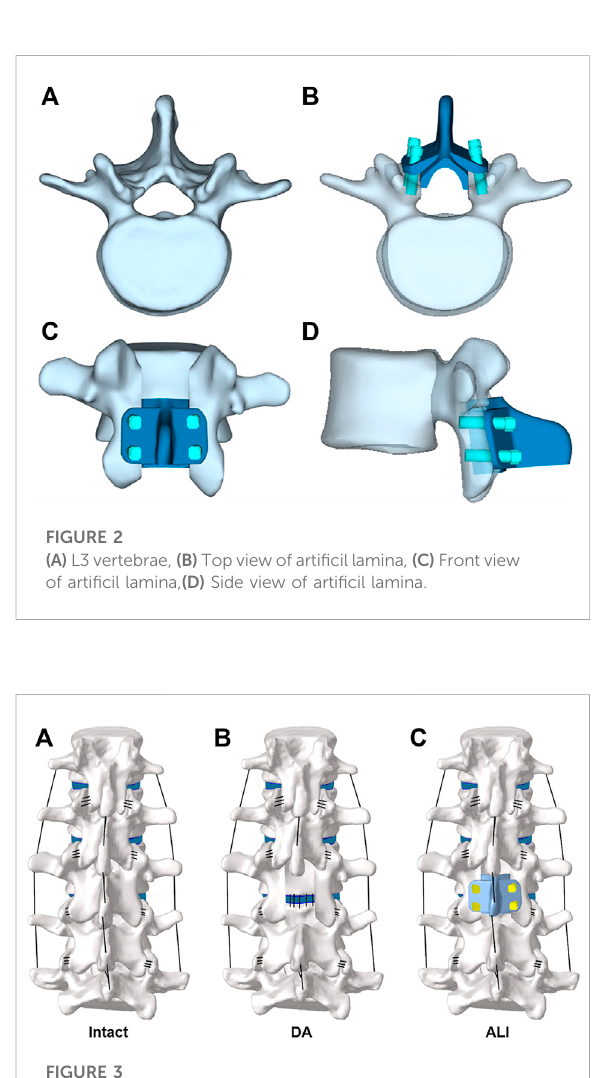
FIGURE 3 FE model of the surgical procedure: (A) Intact, (B) DA, (C)